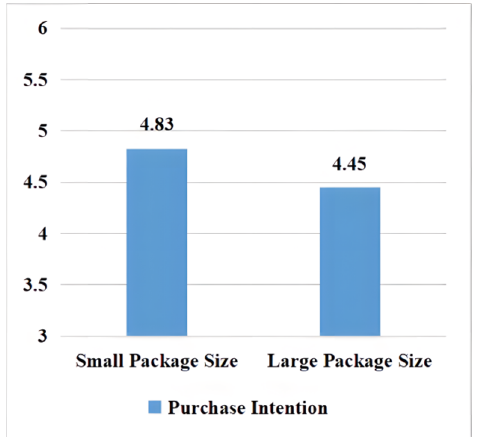
Figure 1. The influence of organic food packaging size on purchase intention.